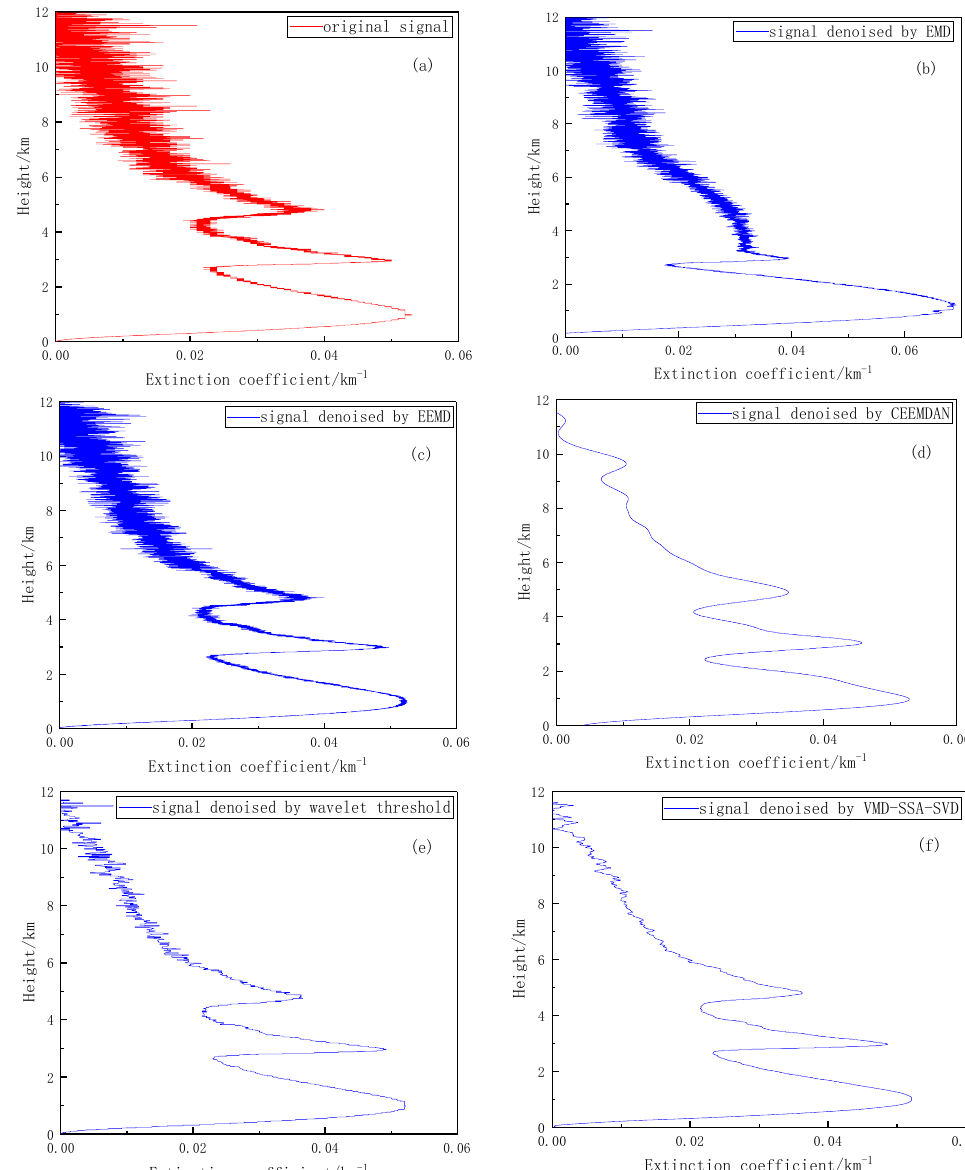
Figure 11. Denoised aerosol extinction coefficient profiles containing the inversion of two cloud return signals by different methods. ( a )Original signal. ( b ) The signal processed by the EMD method. ( c ) The signal processed by the EEMD method. ( d ) The signal processed by the CEEMDAN method. ( e ) The signal processed by the wavelet threshold method. ( f ) The signal processed by the VMD-SSA-SVD method.